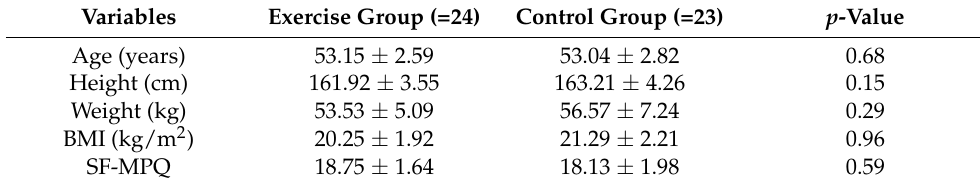
Figure 1. A flowchart of this study. Table 1. Physical characteristics of